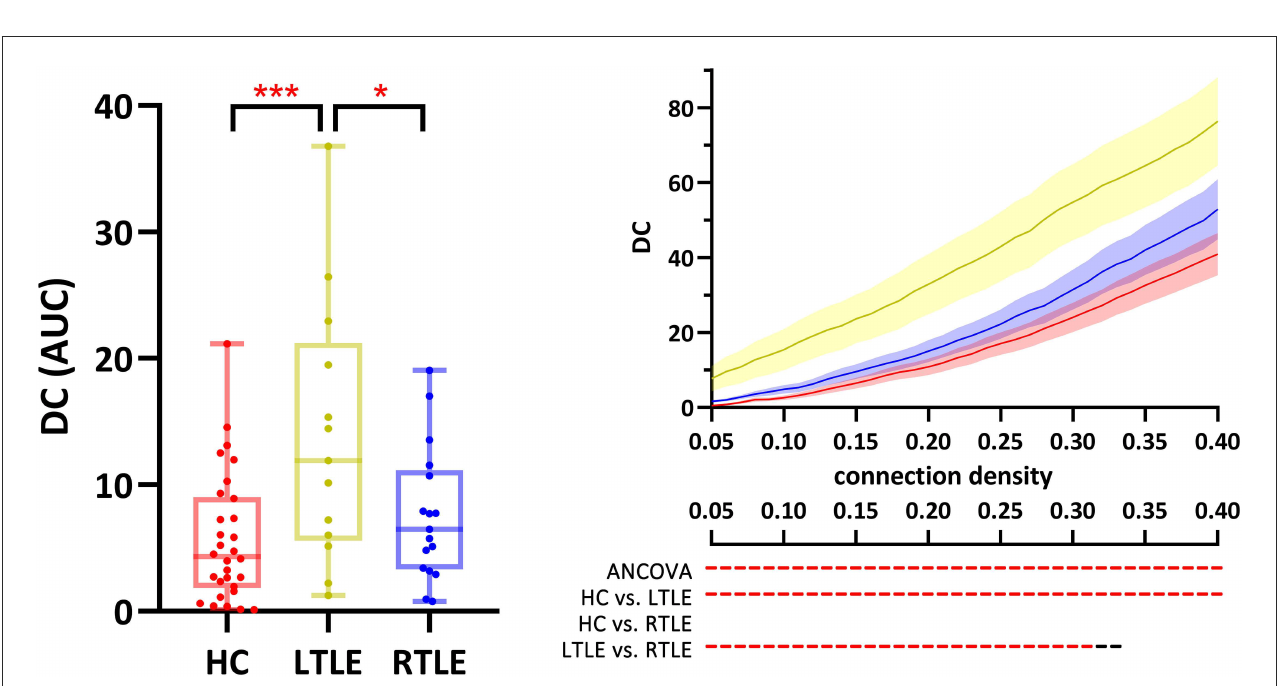
FIGURE3 DC of the right cerebellum lobule III was different across the three groups. Red ***, p < 0.001, FDR-corrected; Red - & *, p < 0.05, FDR-corrected; black -, p < 0.05, uncorrected. The boxplot presents the group comparison of AUC, and the line chart shows the group comparison across all connectivity densities. ANCOVA, analysis of covariates; AUC, area under the curve; DC, degree centrality; HC, healthy controls; IC, independent component; LTLE, left temporal lobe epilepsy; RTLE, right temporal lobe